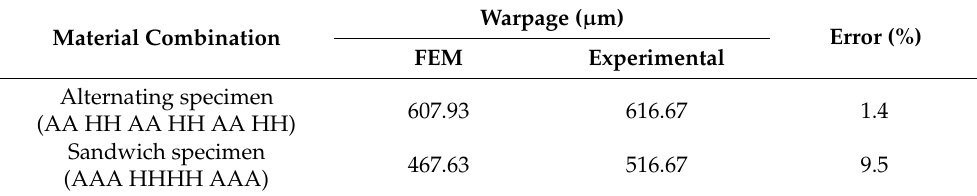
Table 12. Numerical simulation and experimental